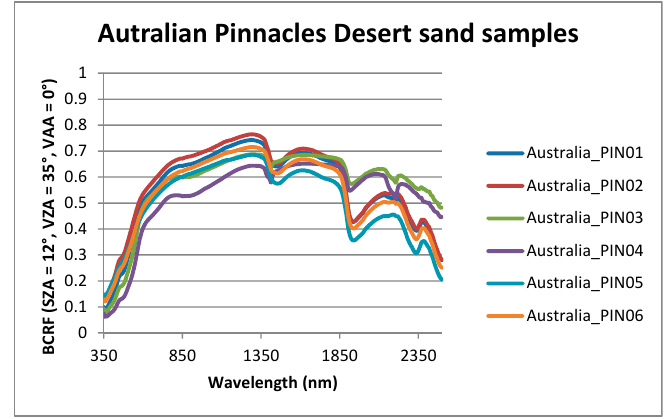
Figure 7. Spectral variation of BCRF for the Australian Pinnacles Desert sand samples .